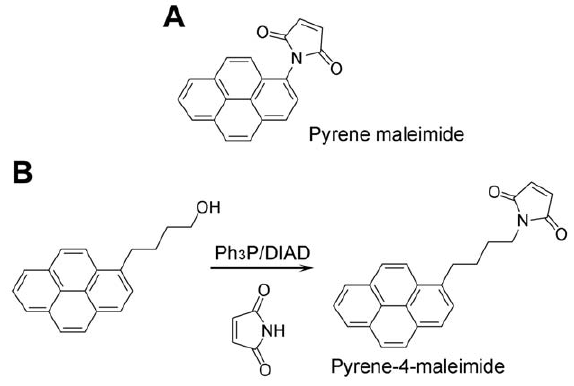
Figure 1. Schematic representation of the pyrene-4-maleimide synthesis and structure. A. Pyrene maleimide structure. B. Pyrene-4- maleimide synthesis route and structure. Ph 3 P: triphenylphosphine; DIAD: diisopropyl azodicarboxylate.